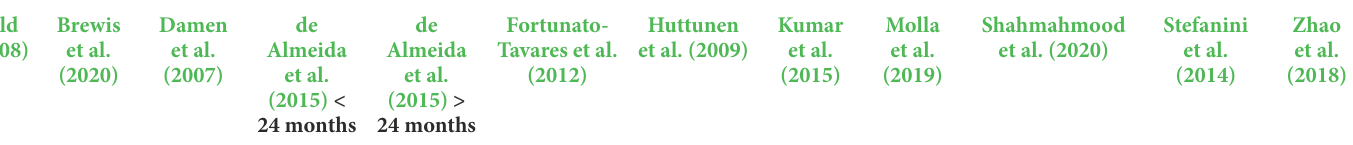
TABLE 4 General functioning subscale Tukey HSD post-hoc mean